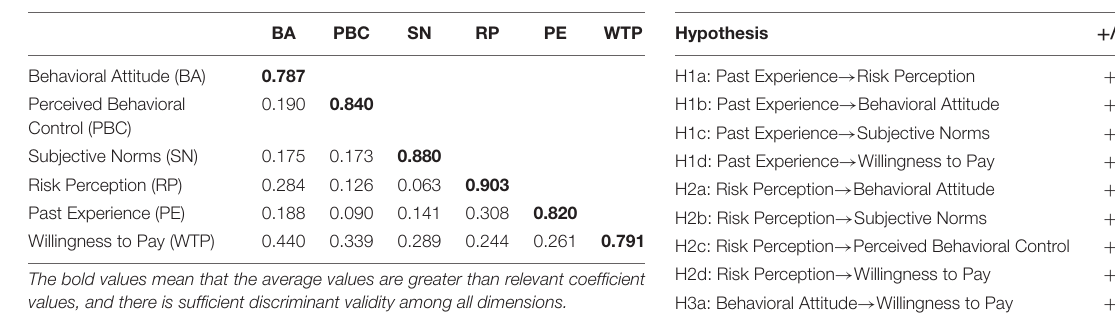
TABLE 4 | Discriminant validity: AVE and Pearson correlation coefficient. TABLE 6 | Hypothesis test results.